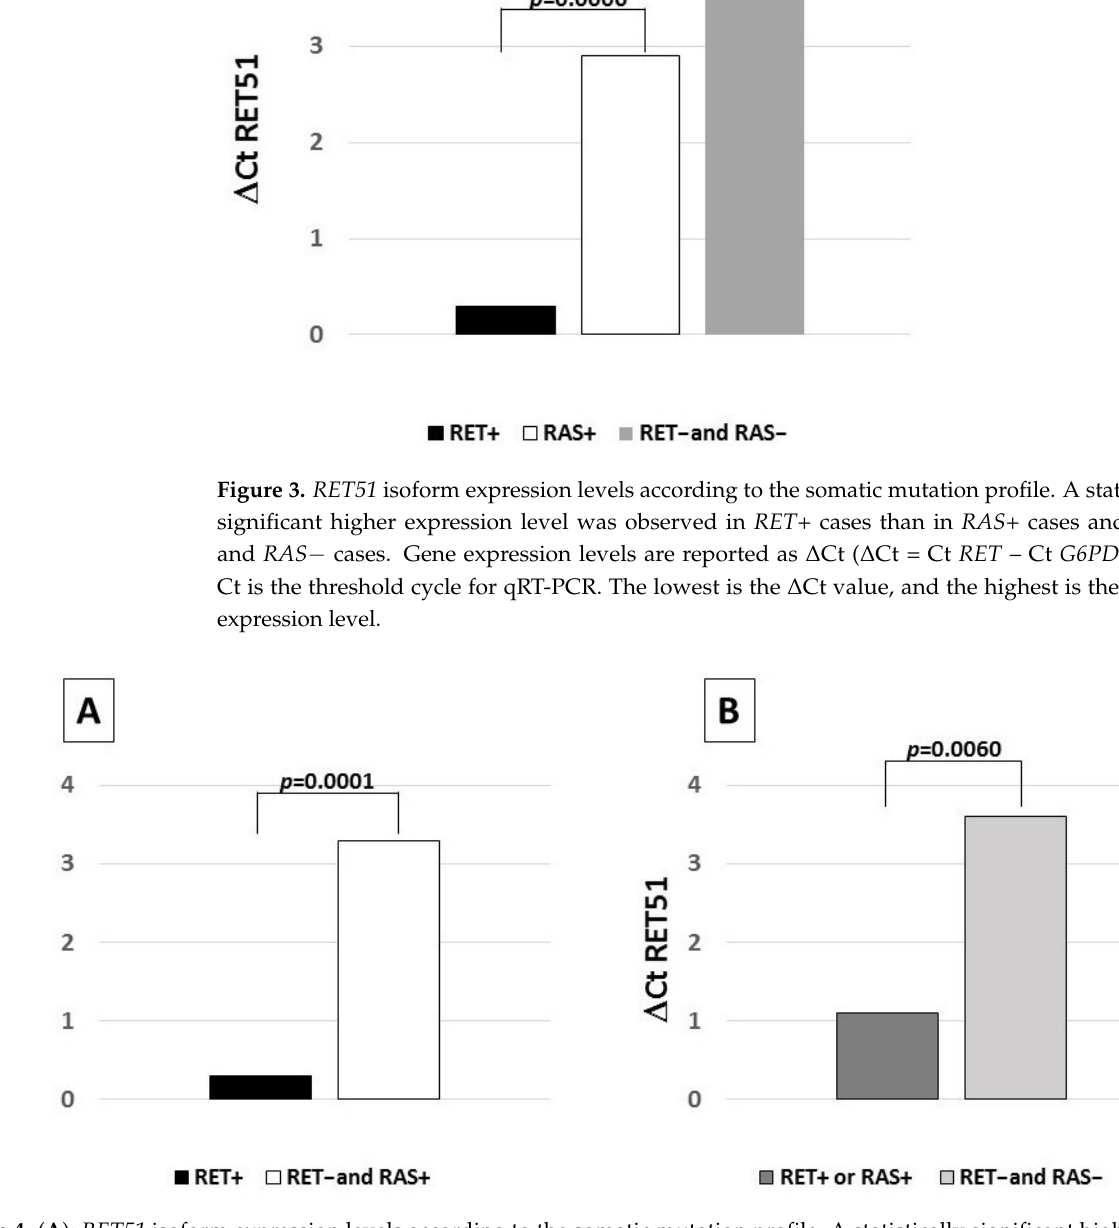
Figure 4. ( A ): RET51 isoform expression levels according to the somatic mutation profile. A statistically significant higher RET51 expression level was observed in RET -positive cases with respect to cases negative for a RET mutation. ( B ): RET51 isoform expression levels according to the somatic mutation profile. A statistically significant higher RET gene expression level was observed in positive cases with respect to cases negative for both genes. Expression levels are reported as ∆ Ct ( ∆ Ct = Ct RET – Ct G6PD ) where Ct is the threshold cycle for qRT-PCR. The lowest is the ∆ Ct value, and the highest are the gene expression